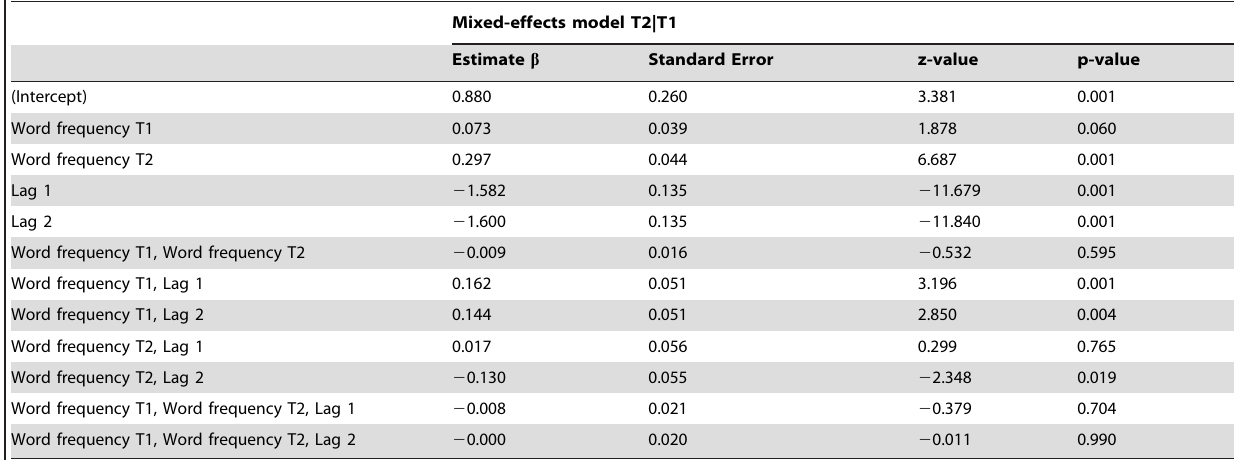
Table 2. The estimates and z-values of the mixed-effects model for T2|T1